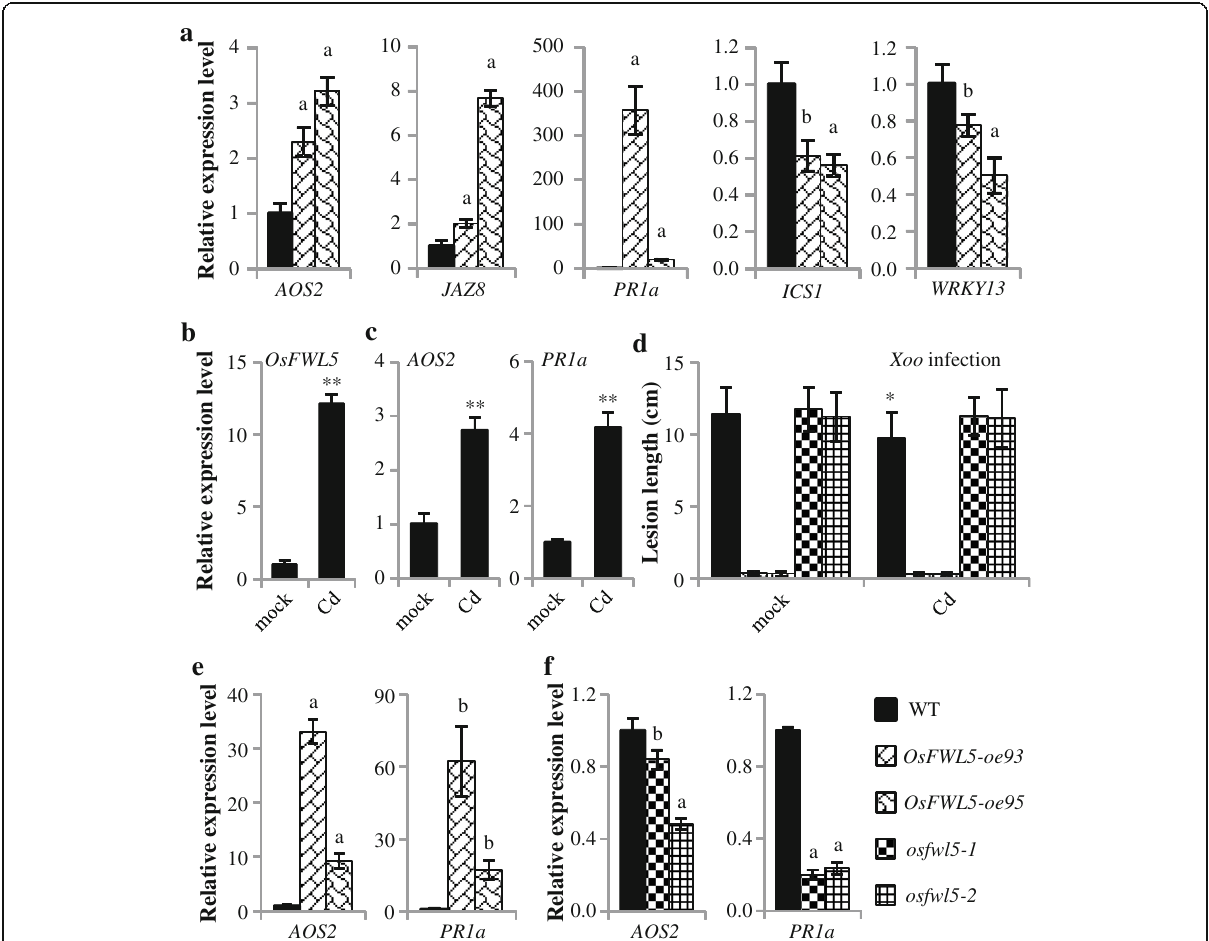
Fig. 2 OsFWL5 affects a set of Pathogenesis-related genes expression and rice response to Cd. ** and * indicate significant differences between Cd treatment and mock treatment at P < 0.01 and P < 0.05, respectively. The “ a ” and “ b ” above bars indicate significant differences compared to wild type (WT) at P < 0.01 and P < 0.05, respectively. Data are means ± SD ( n = 3 for gene expression, and 5 to 15 for lesion length). Primers and methods are listed in additional files 2 and 3. a OsFWL5-oe plants accumulate more JA signaling involved genes AOS2 , JAZ8 and PR1a transcripts, and less SA signaling involved genes ICS1 and WRKY13 transcripts. b OsFWL5 expression was induced by Cd treatment. c AOS2 and PR1a expression was induced by Cd treatment. d Disease resistance analysis after Cd treatment. OsFWL5-oe plants accumulate more AOS2 and PR1a transcripts ( e ), while osfwl5 plants accumulate less AOS2 and PR1a transcripts ( f ) after Cd